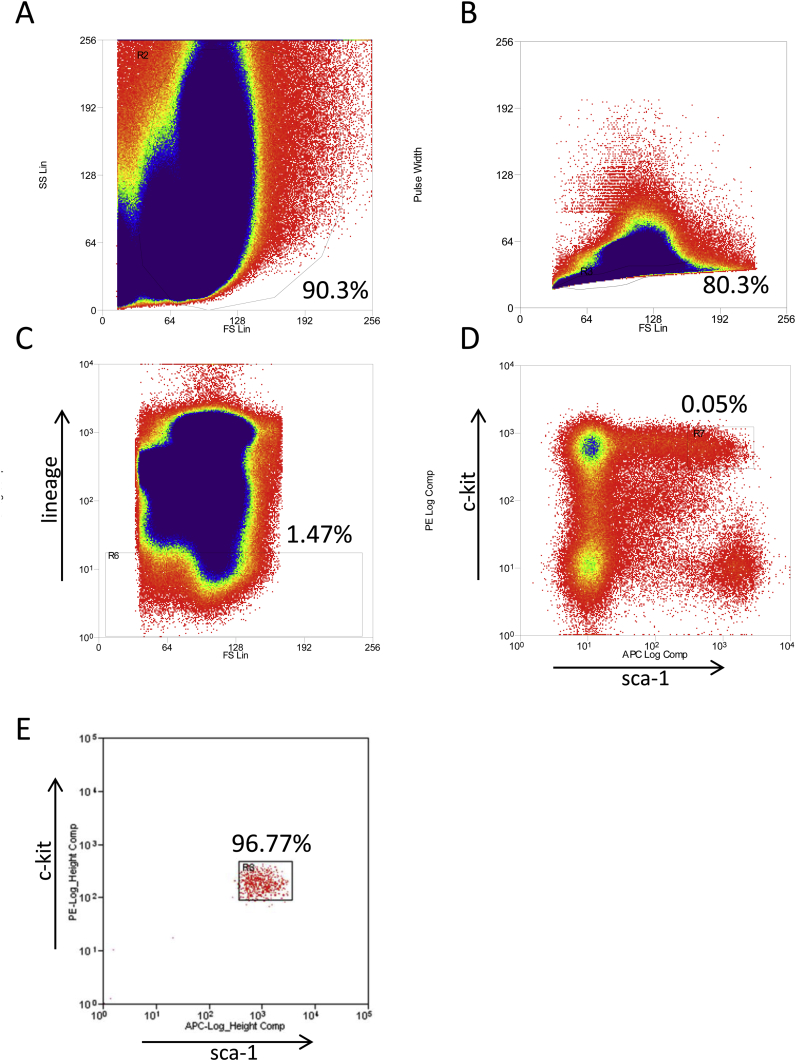
Isolation of KSL cells. Bone marrow cells were obtained from donor mice after dissection of the tibia and femurs by flushing the marrow cavity with Dulbecco's modified Eagle medium + 10% fetal calf serum. Cells were treated with red cell lysis buffer and filtered before labeling with fluorescently conjugated antibodies to lineage specific markers (CD11b, CD8a, CD5, Ter119, Gr-1, and B220), c-kit, and sca-1. Cells were isolated by (A) initially excluding dead cells and debris on a forward scatter–side scatter plot and (B) excluding doublets of cells on a forward scatter–pulse width plot. (C) The lineage-negative population was determined and (D) plotted according to the expression of c-kit and sca-1 surface markers. HSCs were defined as KSL and represented 0.05% of the total bone marrow cell population. (E) The purity of the isolated cells then was checked by determining lineage marker, c-kit, and sca-1 expression on a sample of isolated cells.